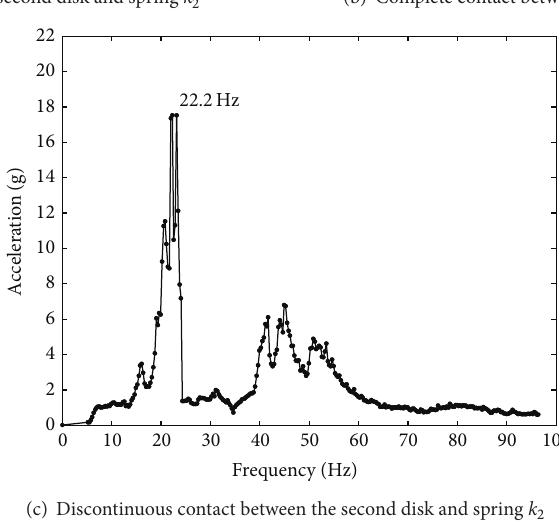
Figure 25: The response of the second disk under different contact conditions.